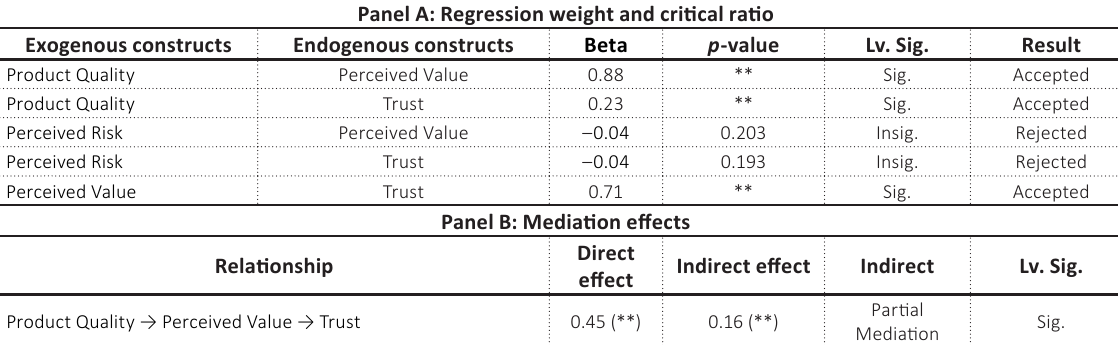
Table 3. Hypotheses results and summary Panel A: Regression weight and critical